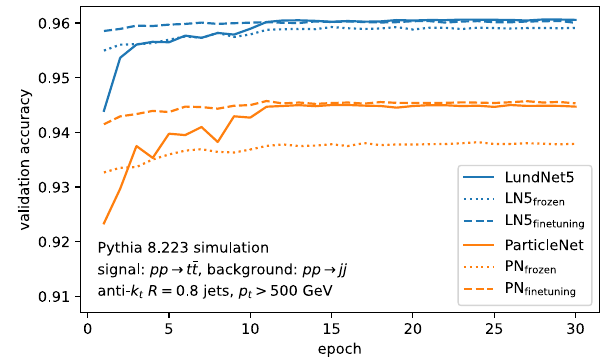
Fig. 3 Validation accuracy as a function of the number of training epochs